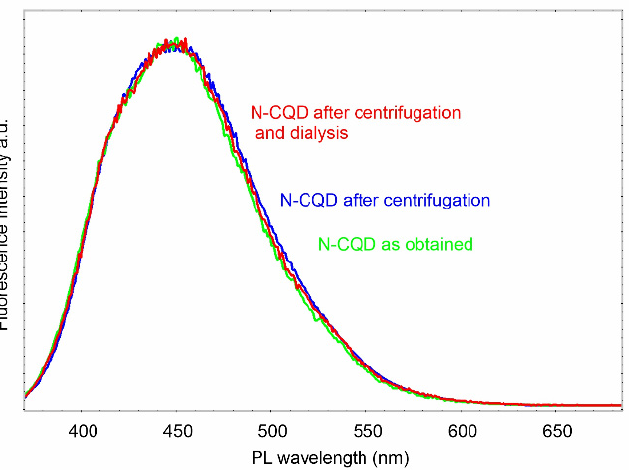
Figure 1. Fluorescence spectra of N-CQD samples subjected to different purification processes (excited at 360 nm).